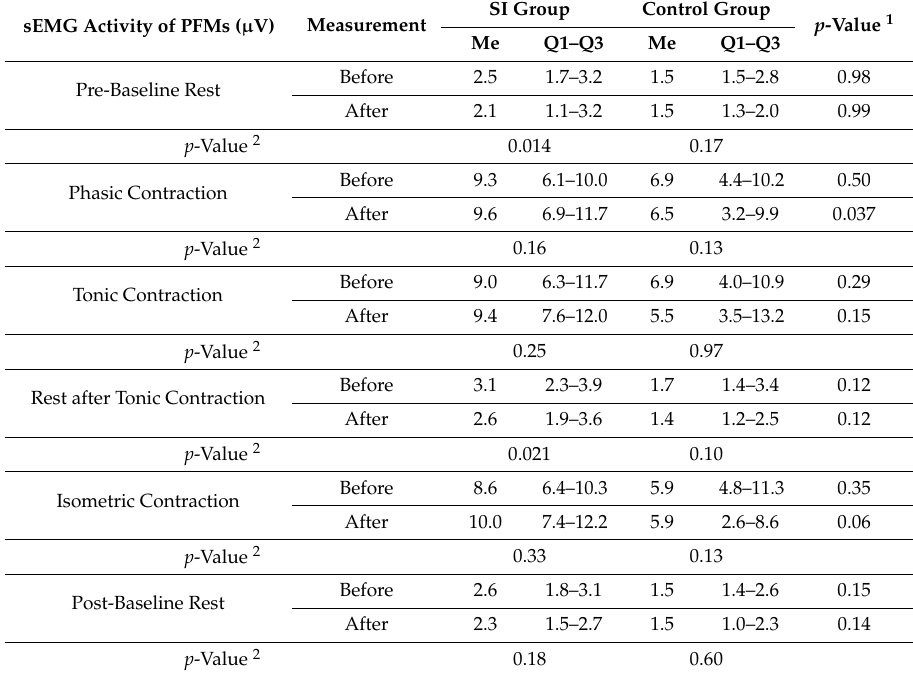
Table 4. Comparison of the sEMG amplitude of PFM ( µ V) before and after the intervention in the experimental (SI) and control groups in supine position.